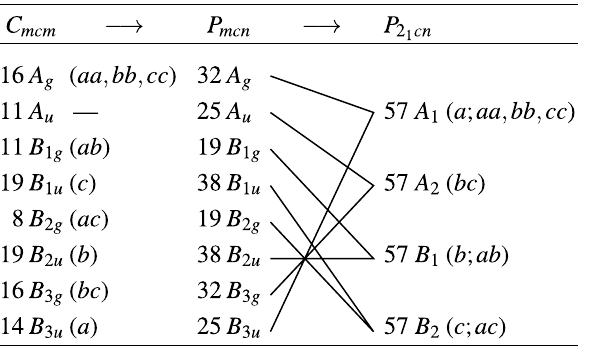
f s = ( 2.5 ± 0.5 ) × 10 10 s − 1 and f s = ( 6.4 ± 0.5 ) × 10 10 s − 1 in the paraelectric and ferroelectric phases, respec-